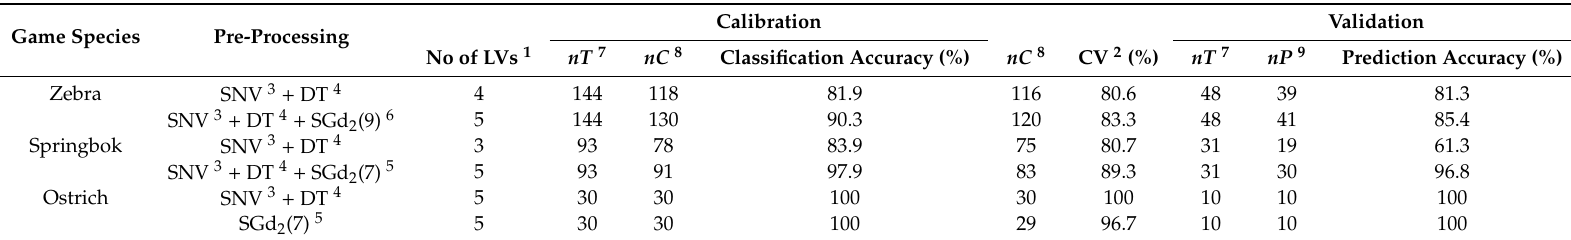
Table 3. An overview of the accuracies of the PLS-DA models with various pre-processing techniques applied to distinguish between the muscle types. Game